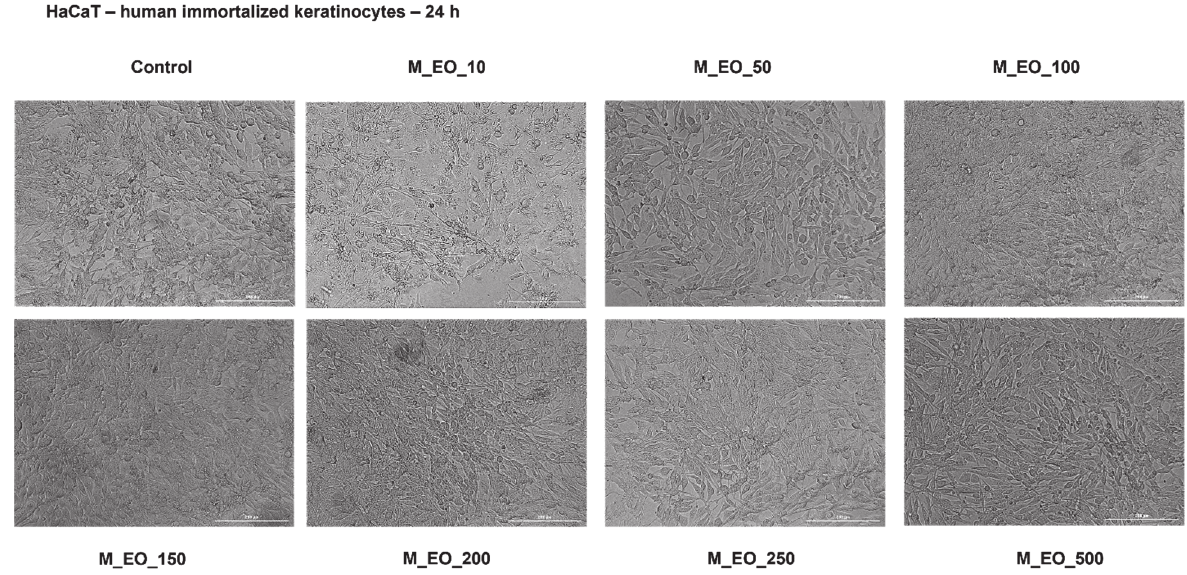
Figure 5 . Morphological aspect of HaCaT cells after treatment for 24 h with Mentha piperita L. essential oil—M_EO (10, 50, 100, 150, 200, 250 and 500 μ g/mL). The scale bar was 200 μ m.